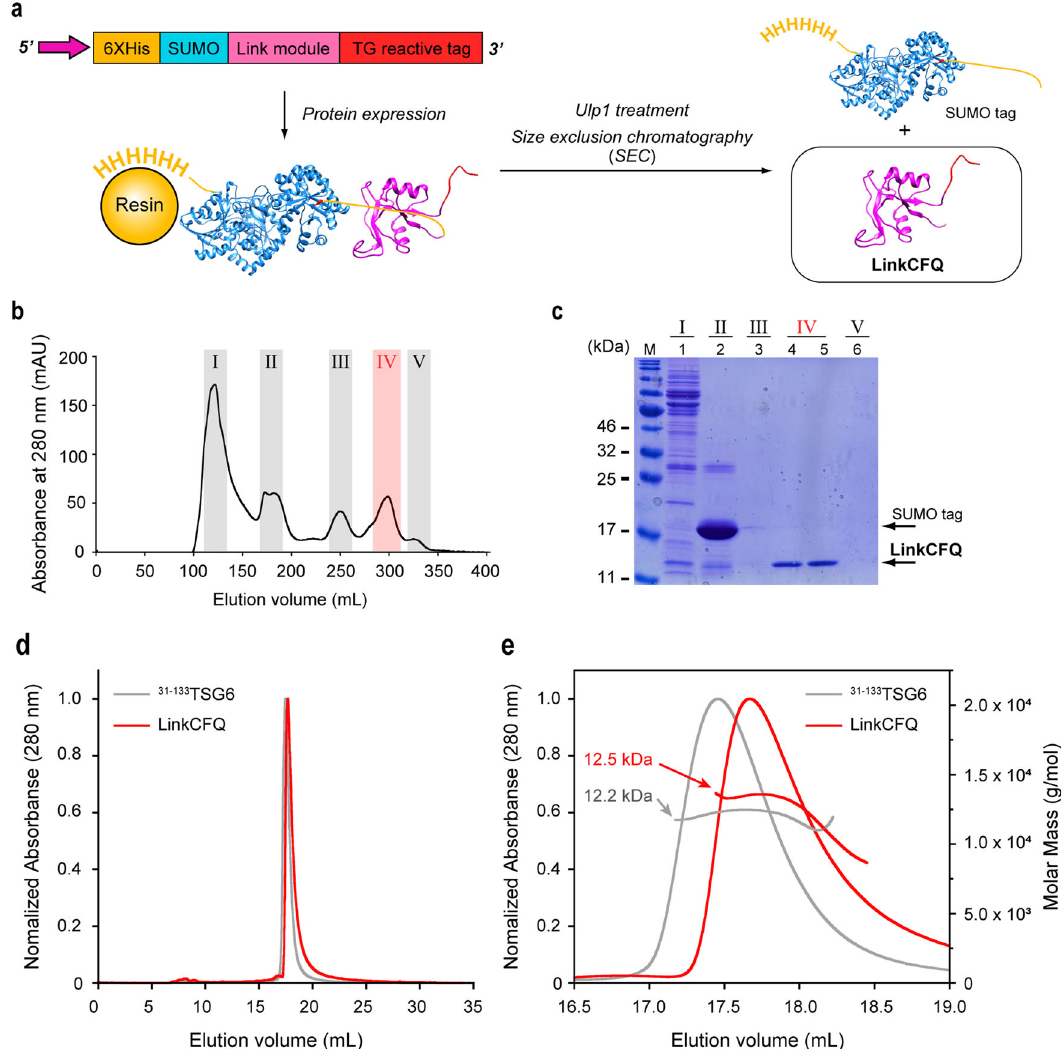
Fig. 1 Expression and puri fi cation of LinkCFQ. a Schematic illustration: a 6HisSUMO-tag was introduced at the N-terminal of LinkCFQ, and LinkCFQ was expressed using BL21(DE3). Following enzymatic digestion with Ulp1, LinkCFQ was puri fi ed via size-exclusion chromatography (SEC). b SEC chromatograph. c Sodium dodecyl sulfate – polyacrylamide gel electrophoresis analysis of the fractions, separated via SEC (lanes 4 and 5 are different samples in fraction IV). All samples are reduced. d , e SEC chromatogram and molecular weight plots of puri fi ed proteins determined via multiangle light